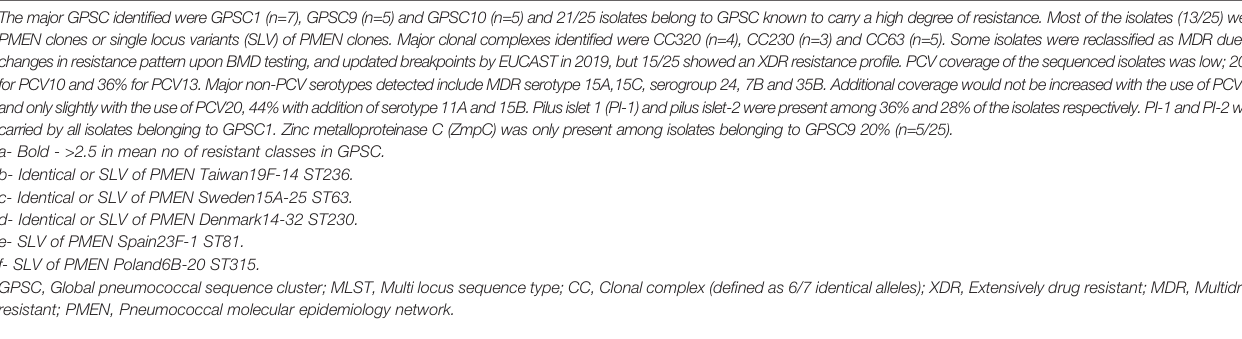
f- SLV of PMEN Poland6B-20 ST315. GPSC, Global pneumococcal sequence cluster; MLST, Multi locus sequence type; CC, Clonal complex (de fi ned as 6/7 identical alleles); XDR, Extensively drug resistant; MDR, Multidrug resistant; PMEN, Pneumococcal molecular epidemiology